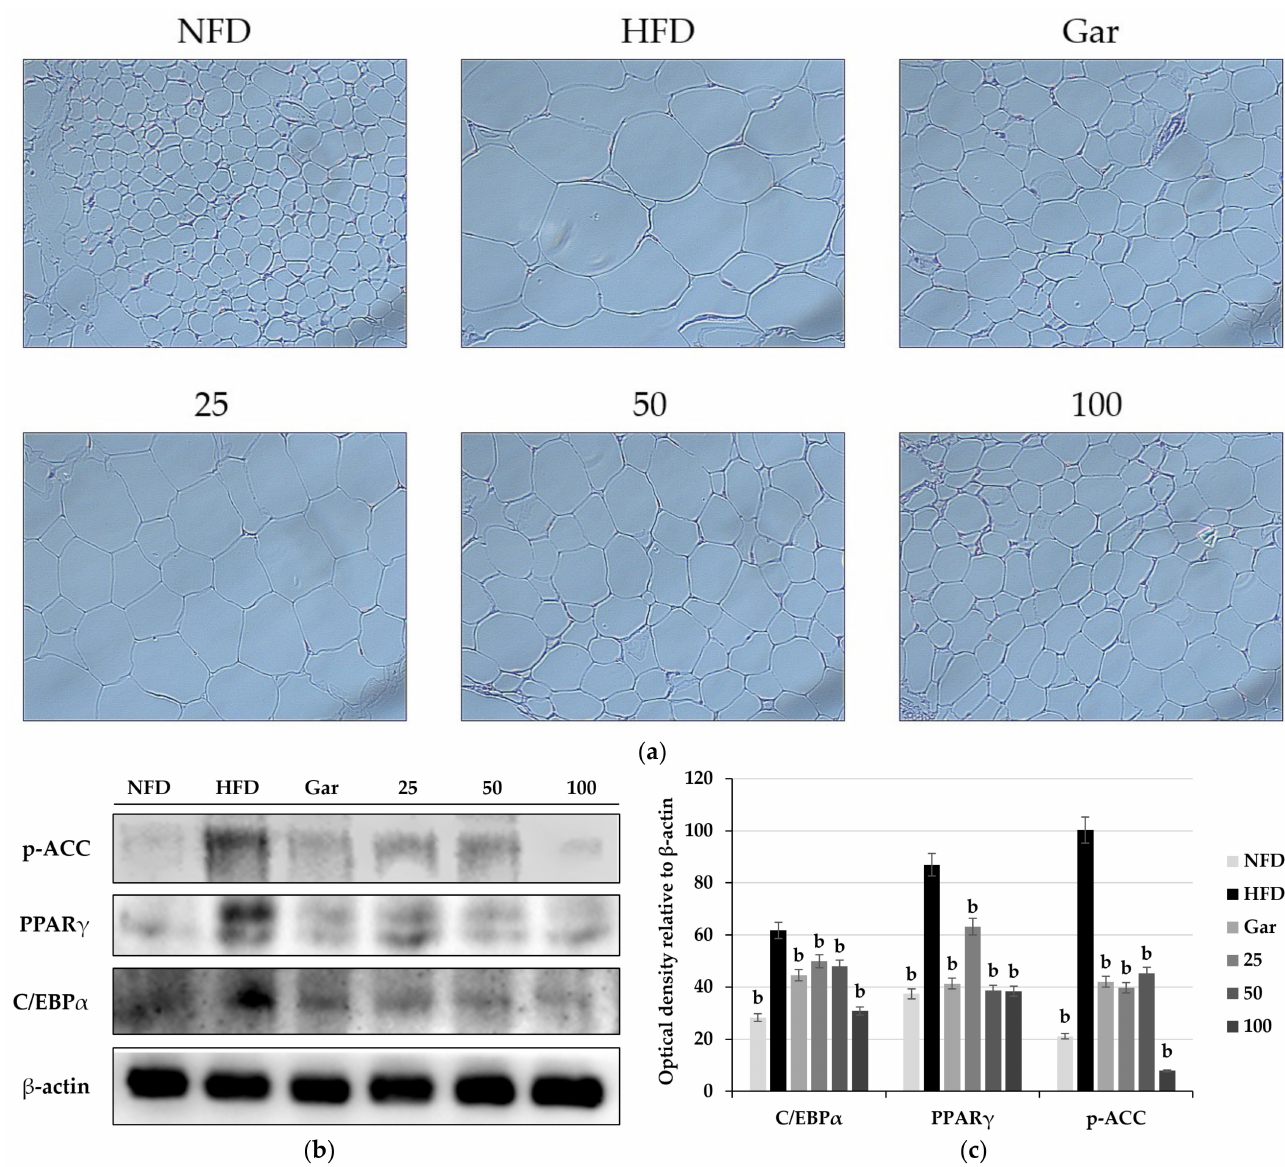
Figure 7. ( a ) Observation of changes in epididymal adipose tissue by H&E staining (400 × , Axiovert100, Oberkochen, Germany). Changes in the expression of p-ACC, PPAR γ , and C/EBP α in epididymal adipose tissue. ( b ) Western blotting and ( c ) semi-quantitative analysis. Statistical analysis was performed using a t -test. b p < 0.01 compared with the HFD group. NFD: normal-fat diet; HFD: high-fat diet; Gar: Garcinia cambogia 100 mg/kg/day; 25: hot-water barley sprout extract (BSE) 25 mg/kg/day; 50: BSE 50 mg/kg/day; 100: BSE 100